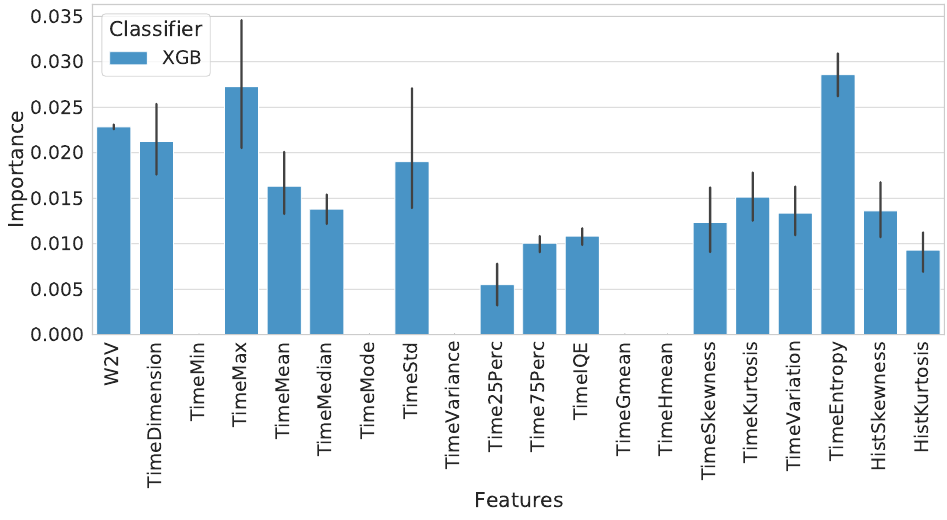
Figure 5. Feature importance obtained using XGB models. The feature vector was composed of word2vec encoded features and time-based